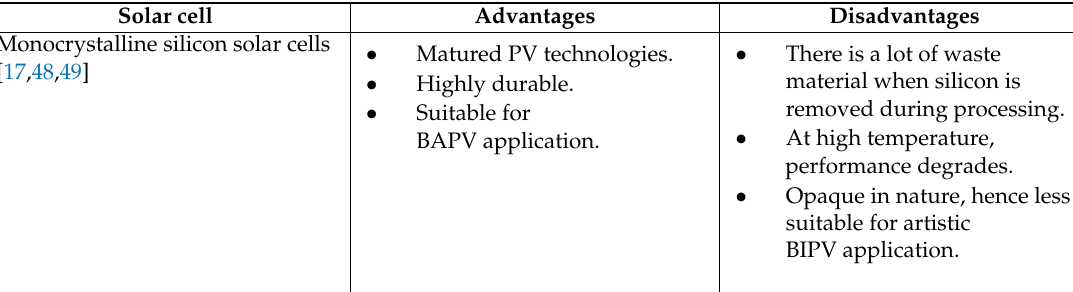
Table 1. Advantages of disadvantages of various solar